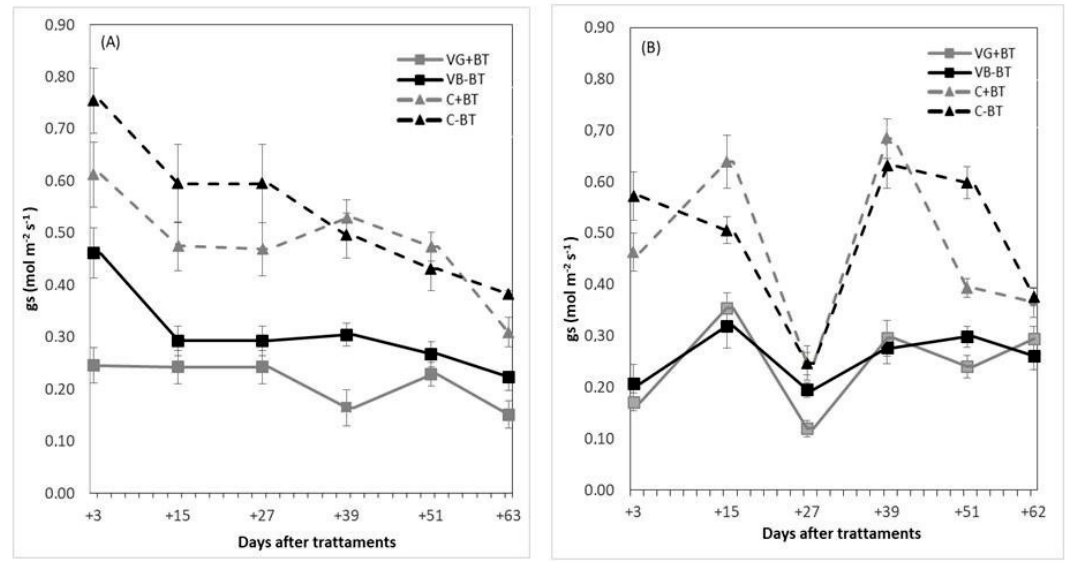
Figure 1. Stomatal conductance (gs) expressed as mol m 2 s − 1 measured in control (C) and treated with Vapor Gard (VG) Falanghina vines in 2013 ( A ) and 2014 ( B ). Bunch thinned vines are reported as BT. Data are averages of 10 replicates ± SE.